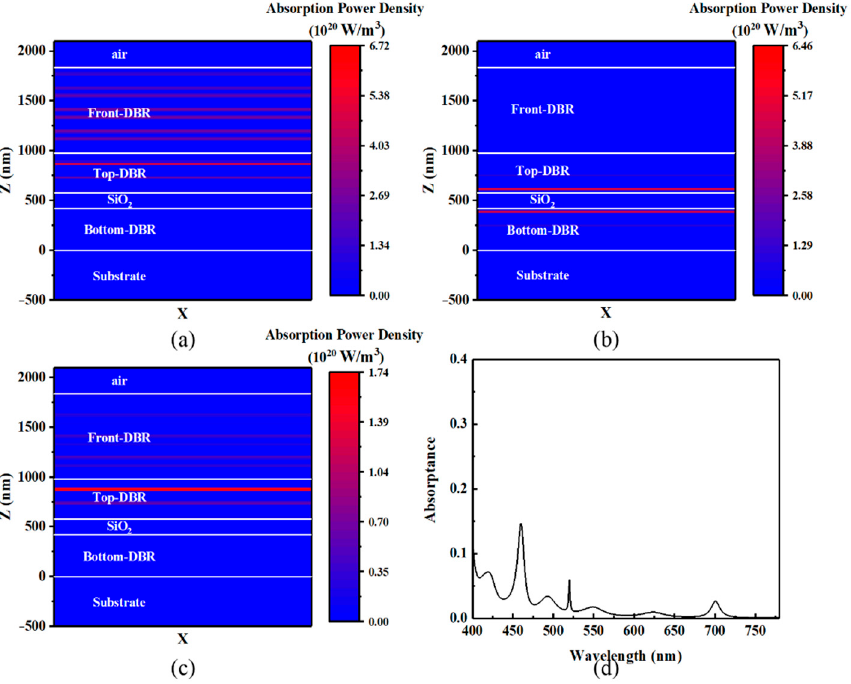
Figure 10. Distribution of absorption power density at 460 nm ( a ), 520 nm ( b ), and 700 nm ( c ) with a 170 nm-thick SiO 2 . Figure ( d ) presents the total absorption of the optical filter.